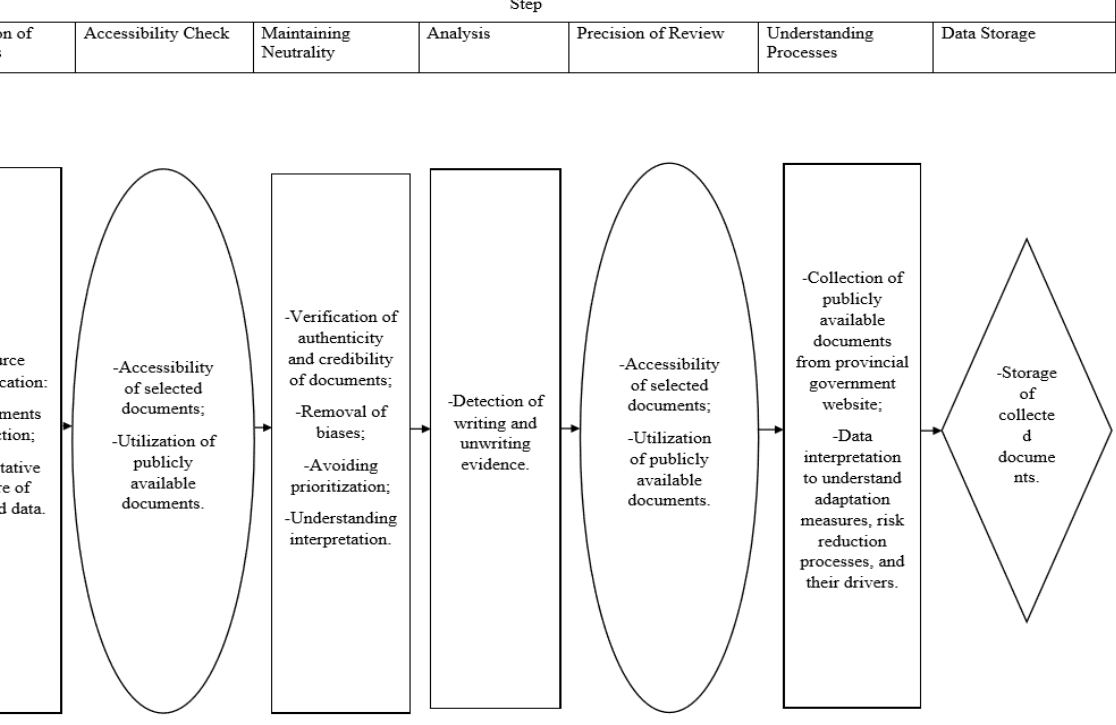
Figure 4. Document review